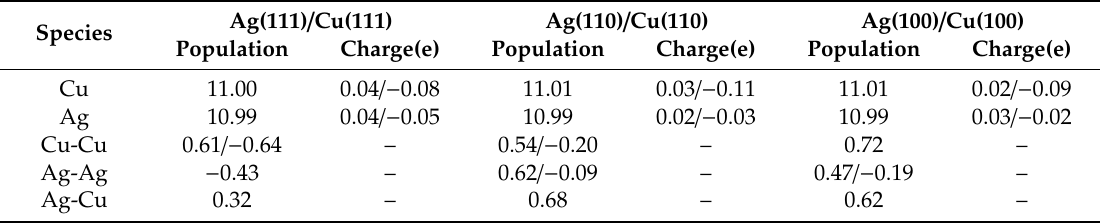
Table 5. The atomic charge and Mulliken bond population of Ag(hkl) / Cu(hkl) interfaces.